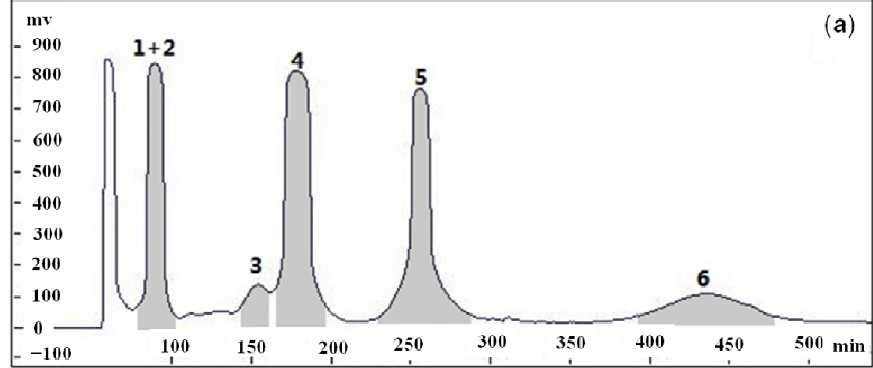
Figure 2. HSCCC chromatogram of the ethyl acetate extract from P. guajava leaves. ( a ) Ethyl acetate extract from P. guajava leaves, ( b ) first time purification of mixture